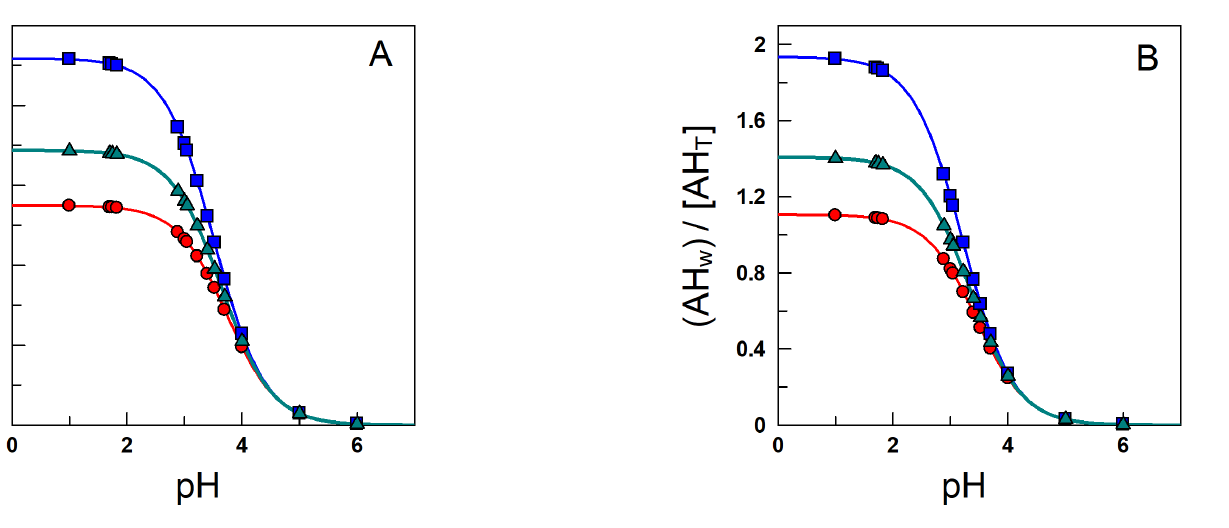
Figure 9. Changes in the effective concentration of the neutral forms of the antioxidants caffeic acid ( A ) and gallic acid ( B ) in the aqueous region relative to the stoichiometric one as a function of pH in 1:1 (blue), 3:7 (teal), and 1:9 (red) v:v oil–water binary mixtures. Values calculated by employing Equation (8).